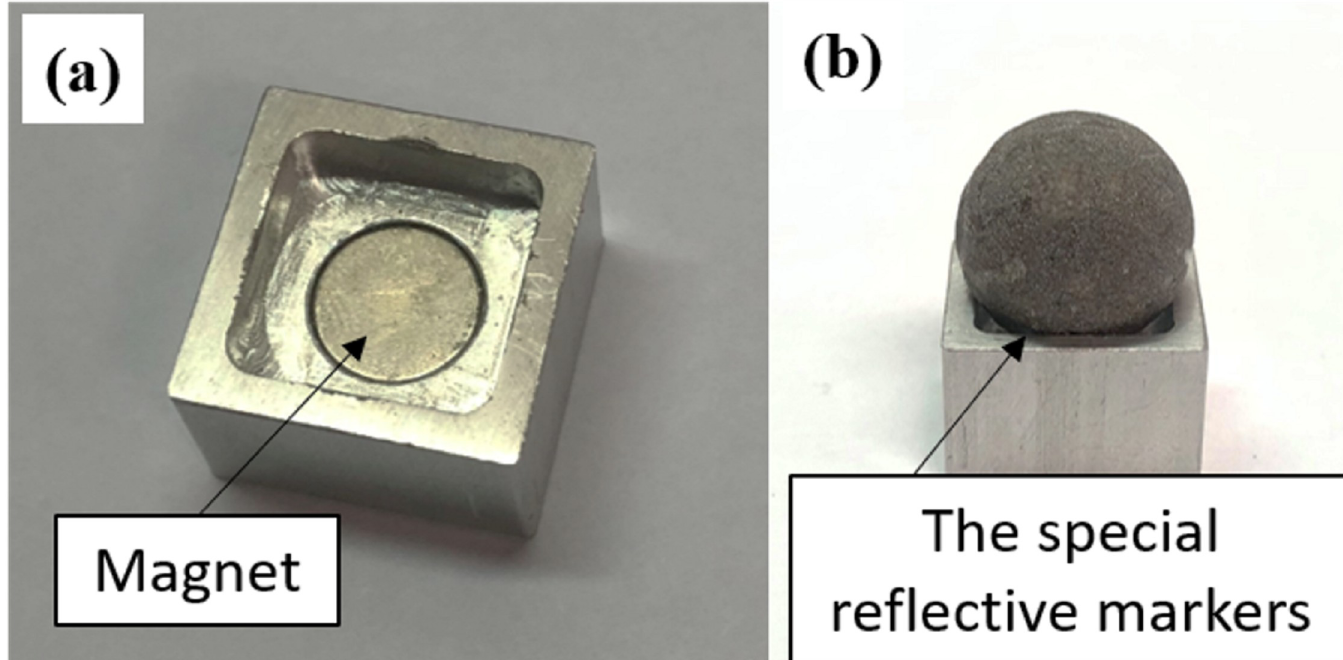
Fig 3. A sample of each of the holes that was used for special reflective marker placement. The special reflective markers (coated with reflective powder) are steel spheres, which can be fixed magnetically onto the alignment board.